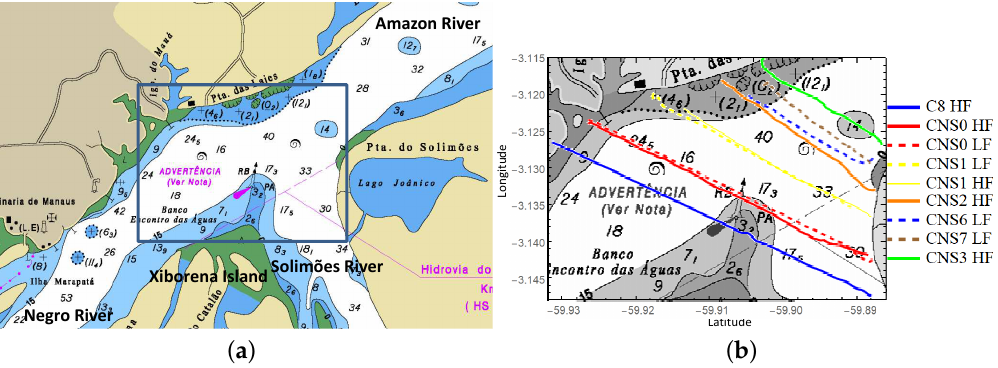
Figure 1. Nautical chart (source: Brazilian Navy [1]) showing the confluence of the Negro and Solimões rivers. The area within the blue square in ( a ) is enlarged in ( b ), where the locations of the transects of a collection of data by the CLIM-Amazon Project are shown. The numbers indicate the depth in meters of the level above which the rivers remain for approximately 90% of the